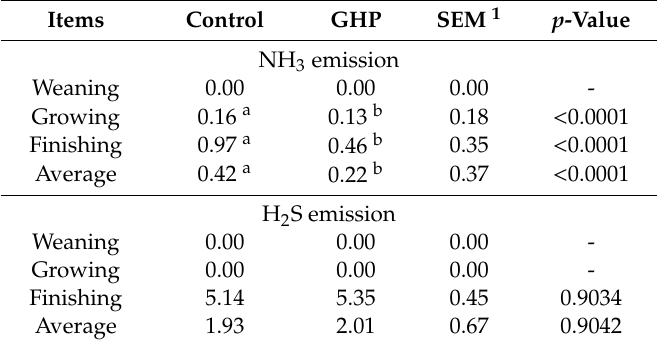
Table 3. E ff ect of the geothermal heat pump (GHP) on ammonia (NH 3 ) and hydrogen sulfide (H 2 S) concentrations in the pig house